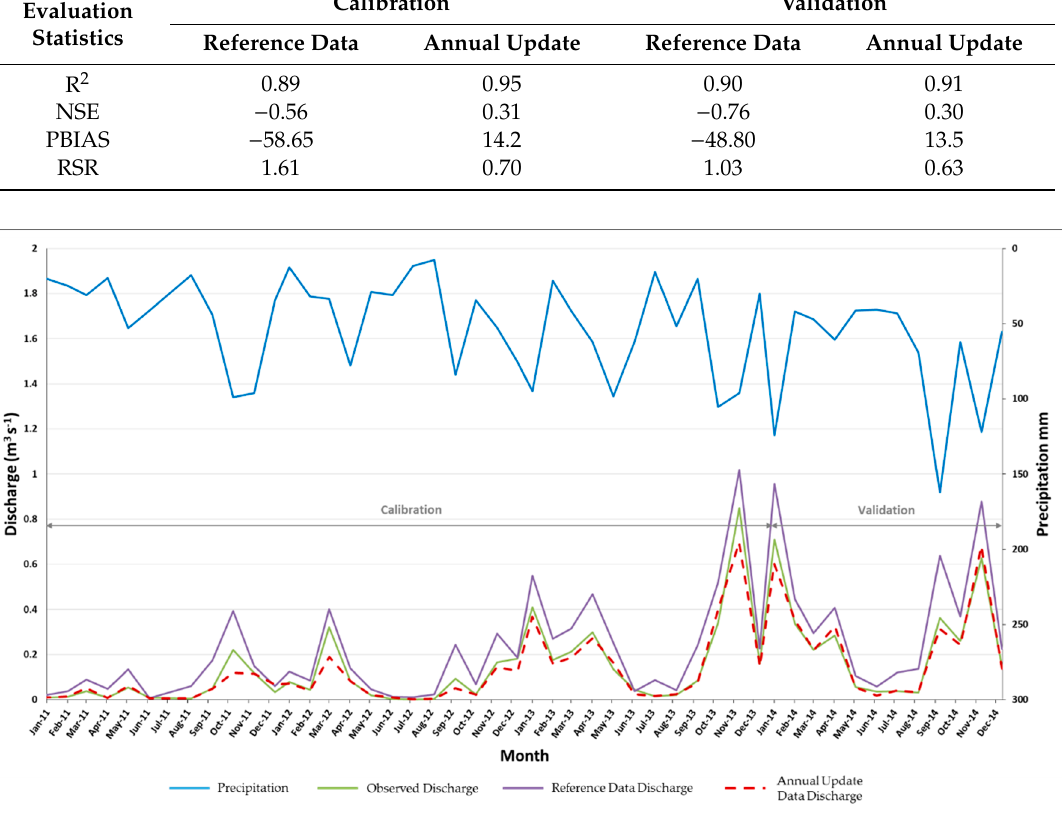
Figure 8. Comparison of the observed and SWAT simulated discharge for monthly calibration (2011– 2013) and validation (2014) at the inlet of the Zazari